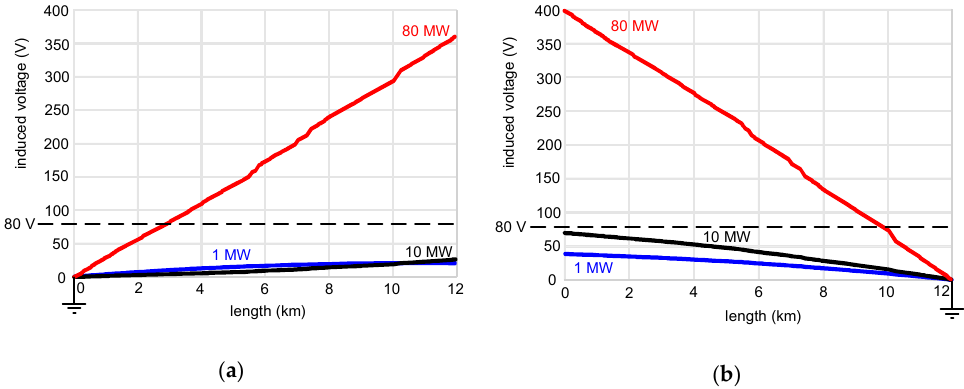
Figure 6. Induced sheath voltages as a function of the cable line length for three values of the transferred power (1 MW, 10 MW, 80 MW), tg φ = 0.4: ( a ) single-point bonding at point p.0 in Figure 2; ( b ) single-point bonding at point p.12 in Figure 2.